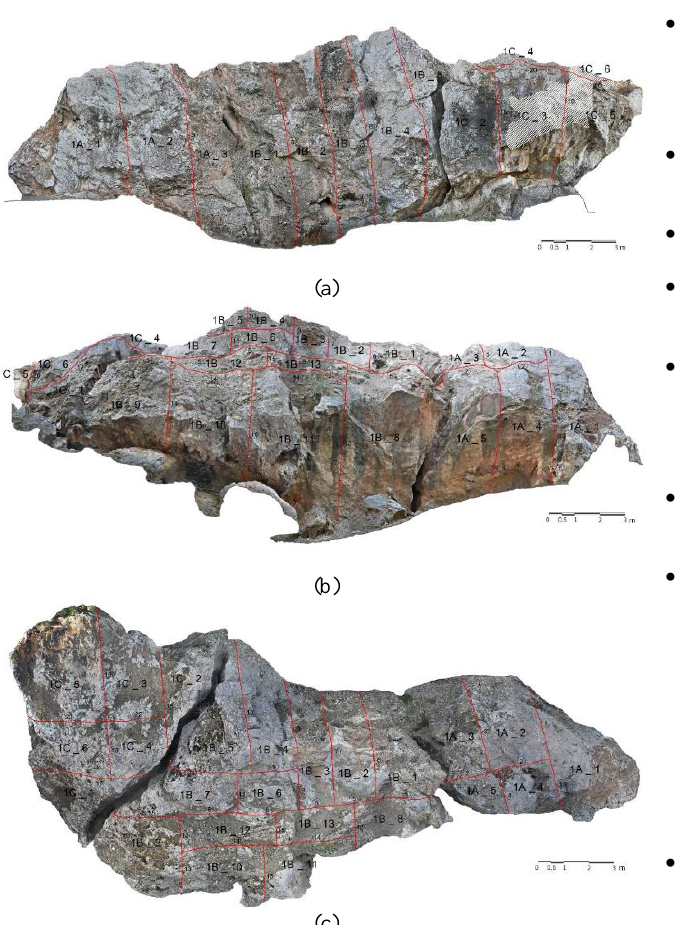
Figure 9: The result of the virtual cutting, (a) elevation facing SW, (b) elevation facing NE, (c) ground plan.